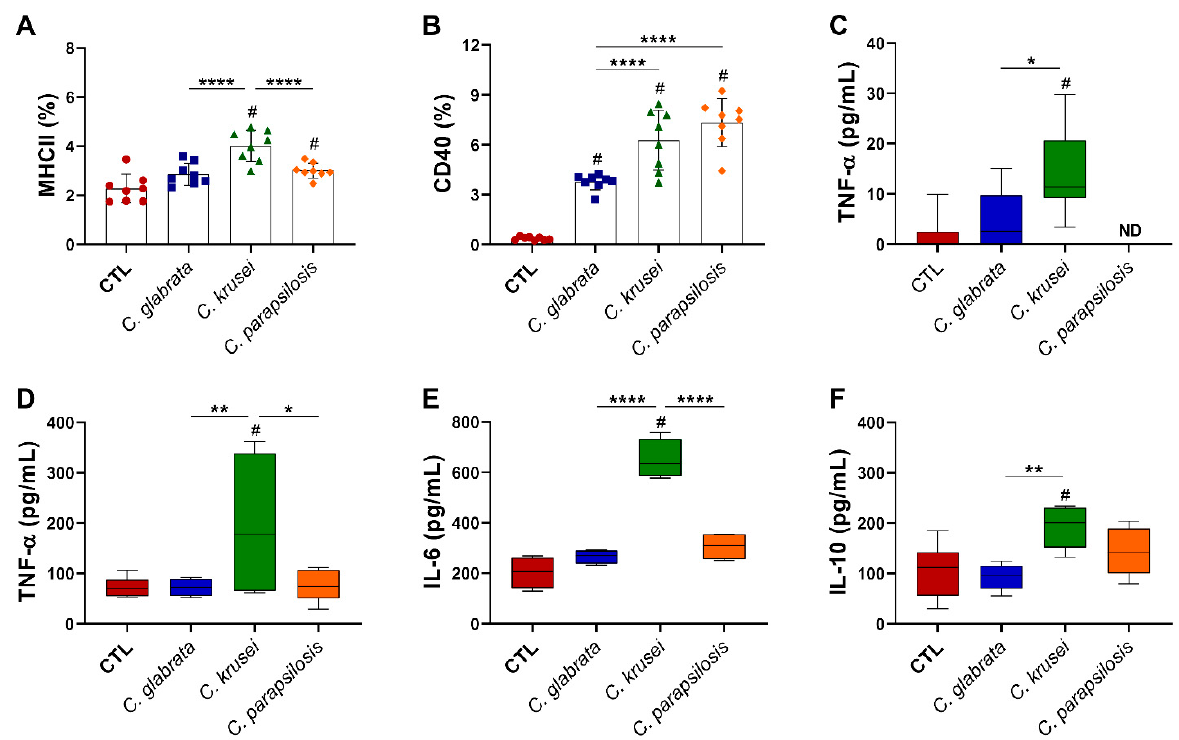
Figure 7. Effect of non- albicans Candida on microglia. Microglia cell line (BV-2, 5 × 10 5 /mL) was infected with non- albicans Candida viable yeasts (1 cell: 1 yeast) and evaluated after 6 ( A – C ) and 24 ( D – F ) hours. Percentage of MHCII ( A ) and CD40 ( B ) were evaluated on CD11b + live (FVS − ) and single cells (FSC-H vs. FSC-A). TNF- α ( C , D ), IL-6 ( E ), and IL-10 ( F ) levels were quantified in cell-free supernatants. The results are expressed as mean ± SD or box ± min to max from two independent experiments (n = 8/group), and * p < 0.05, ** p < 0.01, and **** p < 0.0001. # p < 0.05 in comparison to CTL. ND: note detected.